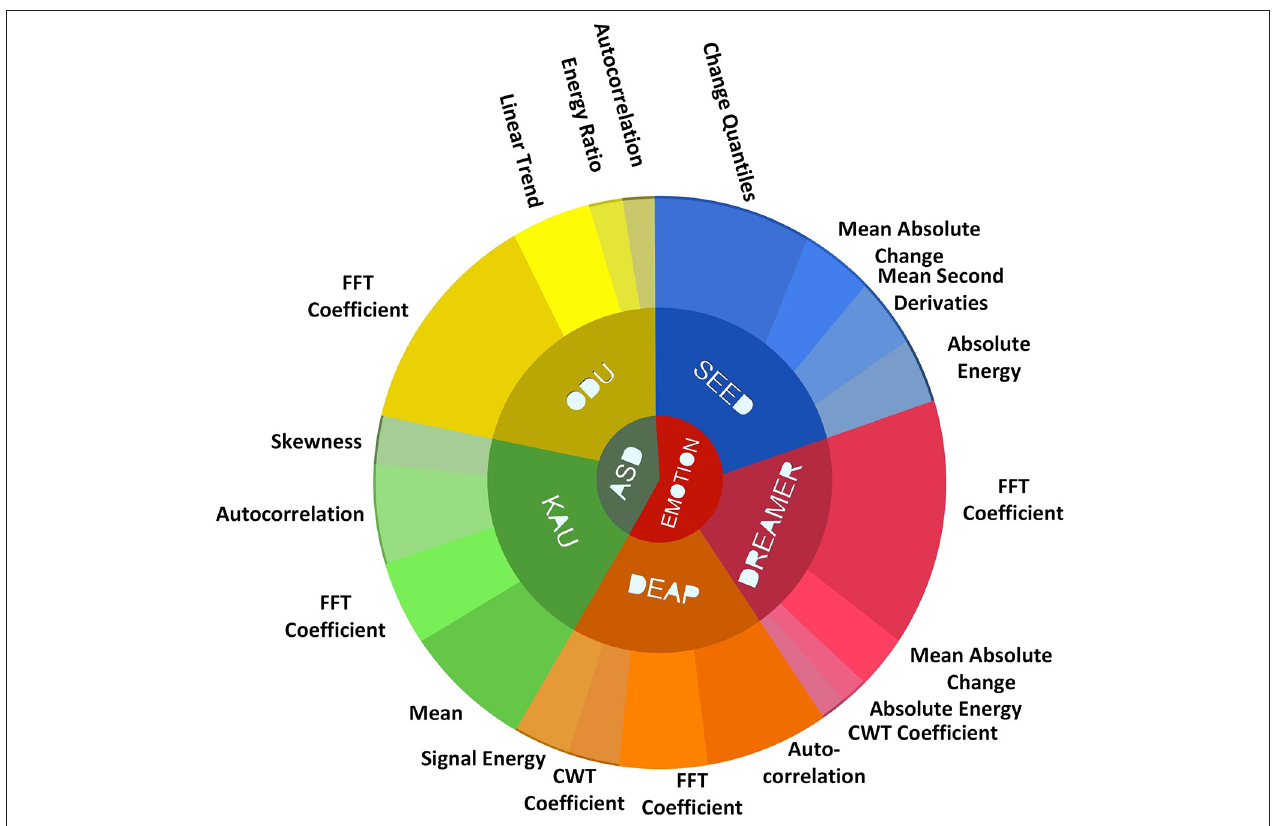
FIGURE 12 | Features wheel diagram for emotions and ASD classification.